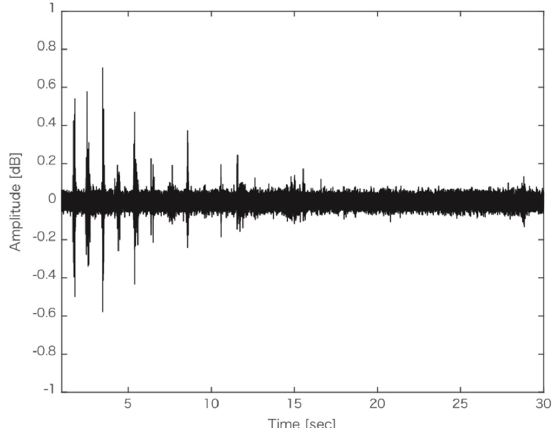
Figure 6. An example of the waveform of the mastication sound.